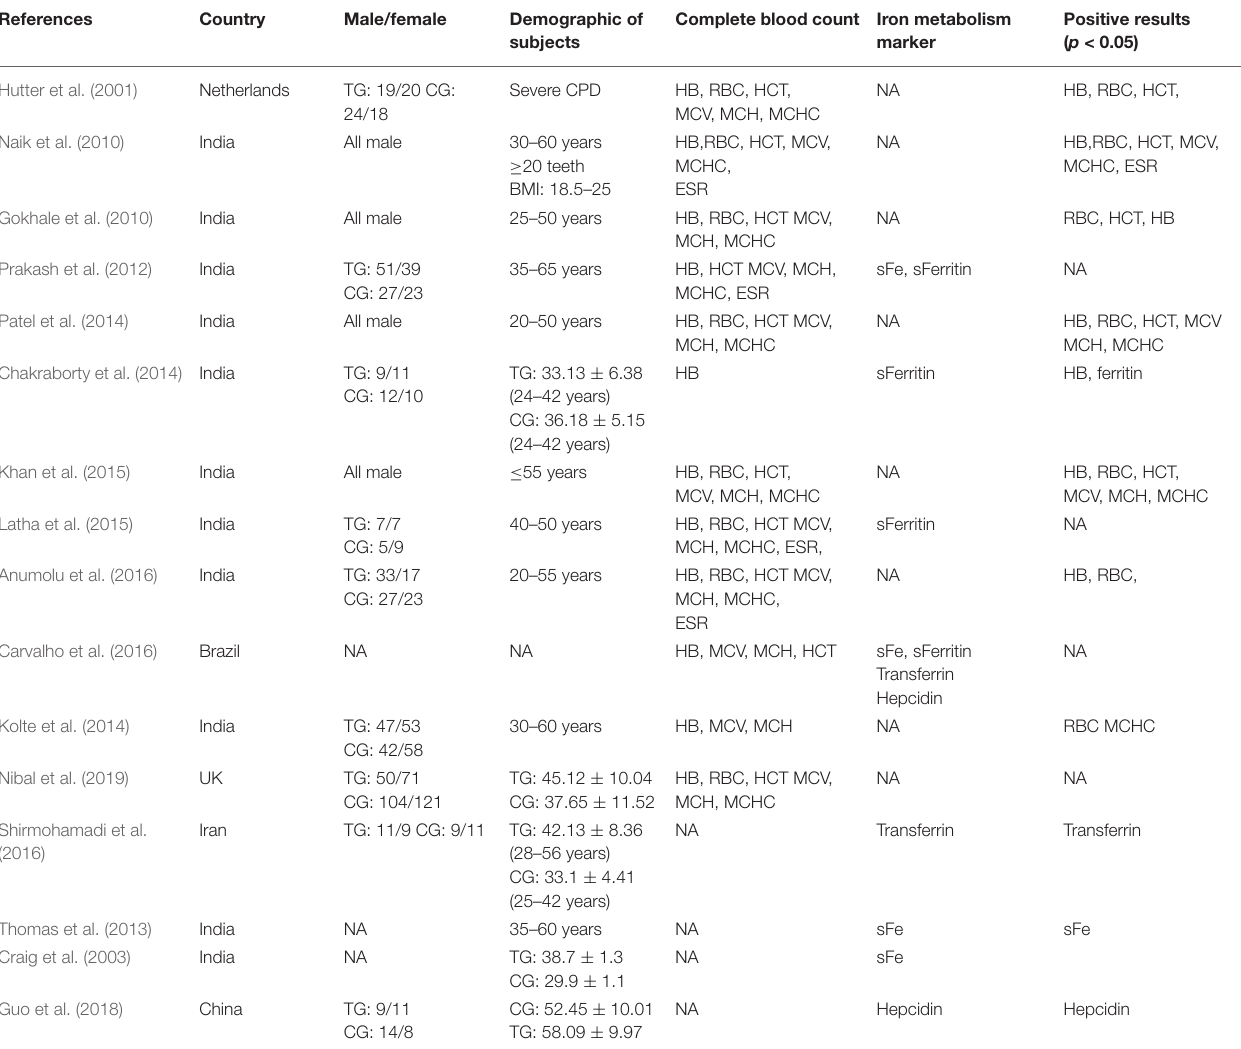
TABLE 1A | Characteristic of included studies. Country Male/female Demographic of